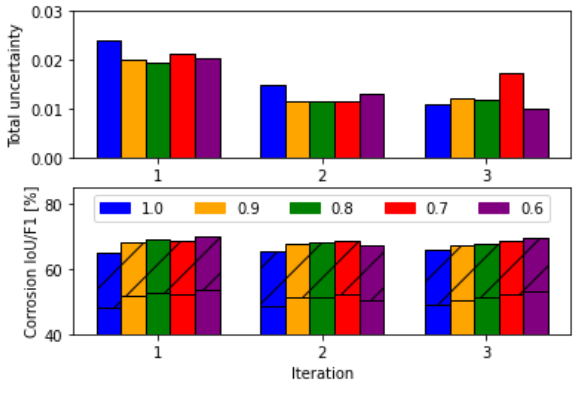
Figure 4. Total uncertainties and corrosion class related metrics of optimal Deeplab V3+ ResNet-50 with respect to test set trained on weakly supervised dataset. Different colours stand for the fraction of deployed weak labels. The hatched bar sections indicate the difference between IoU and F1 score.